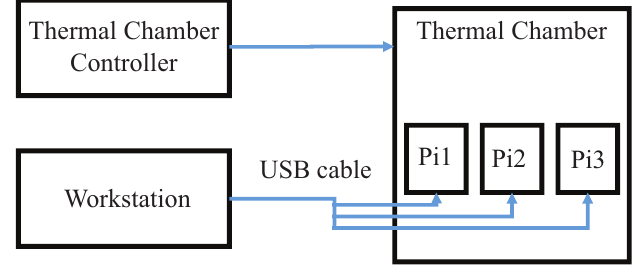
Figure 6. Experimental set up.